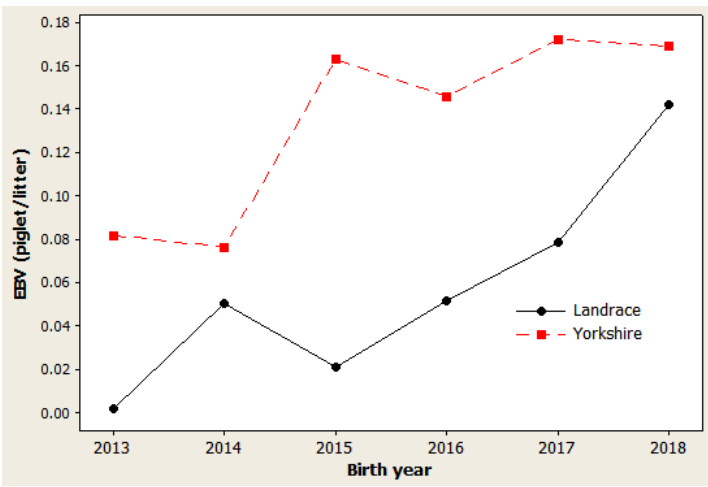
Figure 2. Genetic trend of number weaned in Danish Landrace and Yorkshire pigs by year of birth. Regression coefficients were 0.0233 piglet/yr (p = 0.019) for Landrace and 0.0202 piglet/yr (p = 0.029) for Yorkshire pigs.